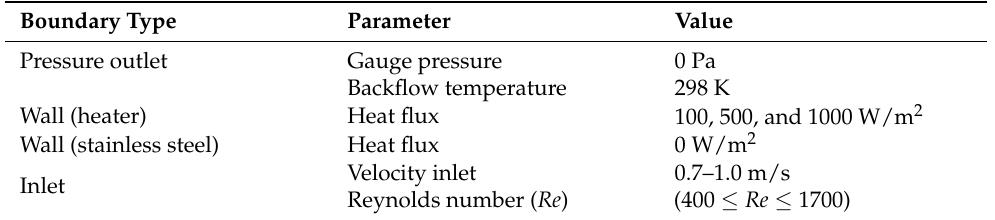
Table 2. Boundary conditions for the CFD